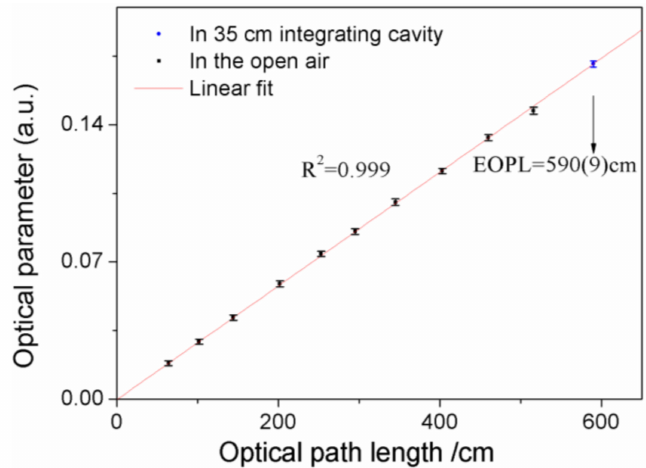
Figure 4. The EOPL (effective optical path length) calibration curve for the cubic integrating cavity between the OP (optical parameter) and optical path lengths in the